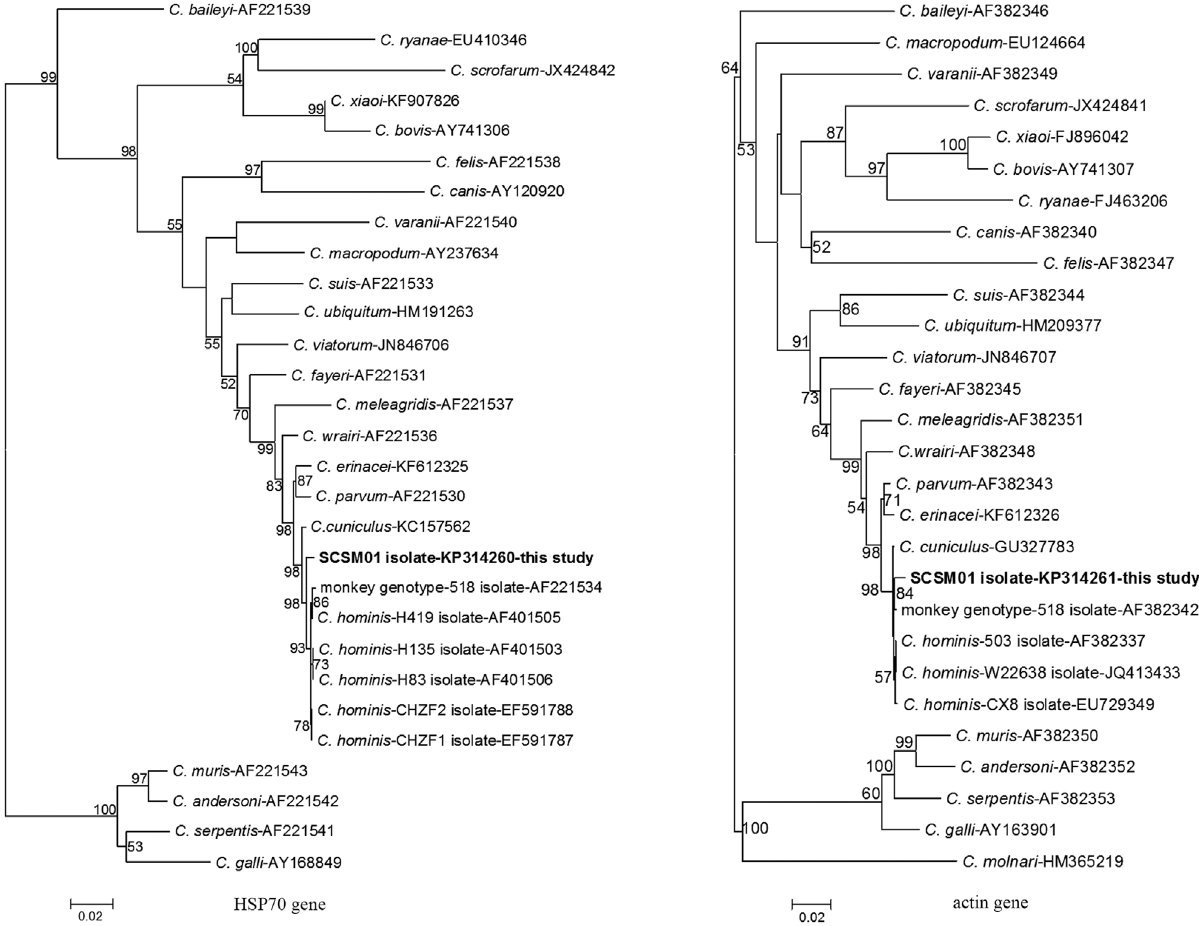
Fig 2. Phylogenetic relationship of Cryptosporidium squirrel monkey isolate in this study to other known Cryptosporidium species/genotype inferred by neighbor-joining analysis of the HSP70 and actin genes sequences based on evolutionary distances calculated using the Kimura two- parameter model. Bootstrap values were obtained using 1,000